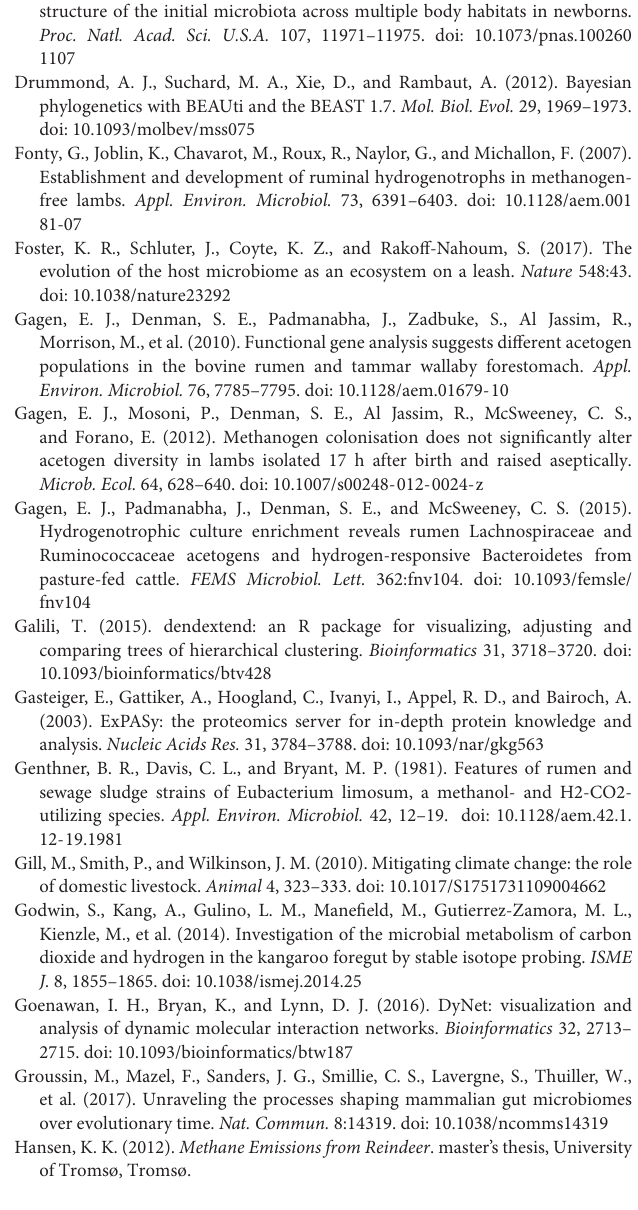
FIGURE S1 | The diversity and richness indices of acetogens (A) and methanogens (B) in the rumen of 14 species. ∗ p < 0.05, ∗∗ p < 0.01, and ∗∗∗ p < 0.001. FIGURE S2 | Correlation of the Shannon diversity index of methanogen and acetogen communities in the rumen of 14 species. FIGURE S3 | Density of the selected microbes in the rumen of 14 ruminant species including total bacteria (A) , protozoa (B) , methanogens (C) , and